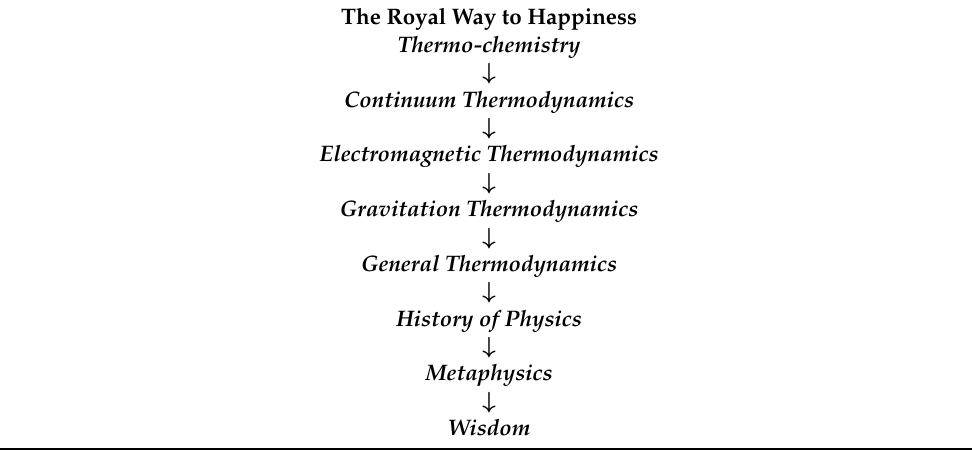
Table 1. The frame of knowledge and scientific activity of Duhem and